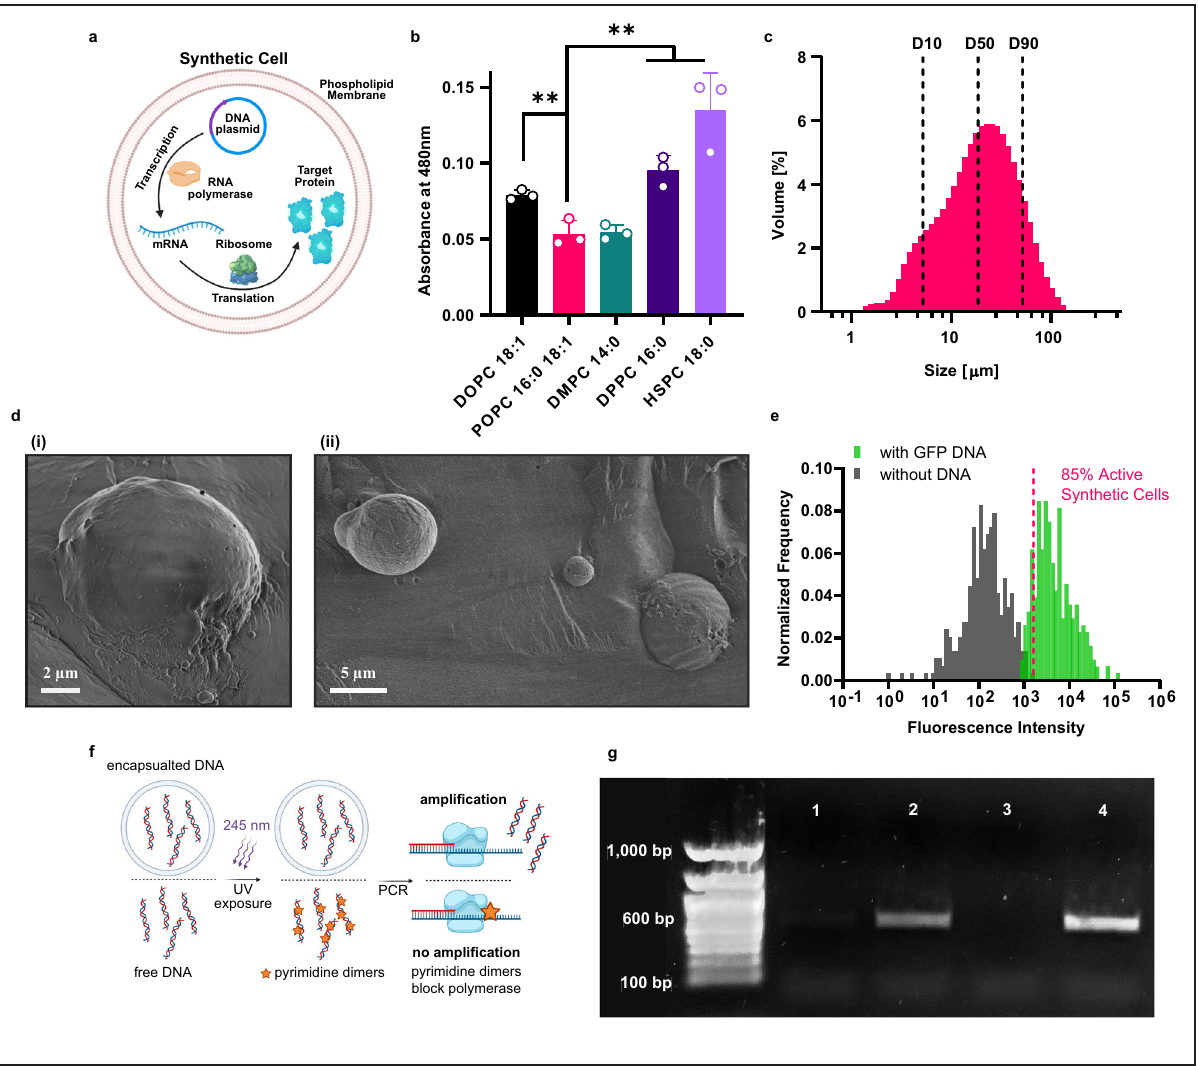
Fig. 1 Optimizing the lipid composition for light-interacting synthetic cells. a Illustration of a protein producing synthetic cell. b The effect of the lipid membrane composition on blue light absorbance in liposomes. Data is expressed as the mean ± standard deviation ( n = 3 independent samples). Nested two-tailed t -test P values; **p = 0.0079, **p = 0.0058, **p = 0.0055 for comparisons of POPC vs. DOPC, DPPC and HSPC, respectively. c Size distribution of synthetic cells with 1:1 (w/w) POPC:cholesterol membrane composition. Data is expressed as mean of n = 3 independent samples. d Morphology of 1:1 (w/w) POPC:cholesterol synthetic cells imaged with cryogenic scanning electron microscopy (cryo-SEM). e The percentage of active synthetic cells measured using imaging fl ow cytometry of GFP-expressing synthetic cells ( n = 331 synthetic cells without DNA and n = 308 synthetic cells with GFP DNA). Frequency is normalized to the total number of cells in each sample. f Illustration of a linear DNA oligonucleotide, encapsulated in a synthetic cell or free in solution, exposed to UV radiation. Formation of pyrimidine dimers is detected using PCR ampli fi cation. g Gel electrophoresis of the ampli fi ed PCR product of linear DNA after exposure to UV radiation with and without encapsulation in synthetic cells. Lane 1: free DNA exposed to UV. Lane 2: encapsulated DNA exposed to UV. Lane 3: no DNA control. Lane 4: untreated DNA control. This experiment was reproduced n = 3 times. Source data are provided as a Source Data fi transcription and translation processes), by measuring the fl uorescence intensity of SCs encapsulating a CFPS solution and were produced using the emulsion transfer method. This method ’ s simplicity, high encapsulation ef fi ciency, and high yield GFP encoding DNA (Fig. 1e). 85% of the SCs were active and make it preferable for achieving high overall protein displayed higher fl uorescence levels than the maximal back- production 30 . Light scattering was used to determine the obtained size distribution, spanning between 1-200 μ m with average D10, population of SCs without a DNA template. D50 and D90 values (corresponding to the 10%, 50% and 90% marks in the cumulative size distribution curve) of 5.2, 18.6 and 51.8 μ m, respectively (Fig. 1c). Cell morphology and size range